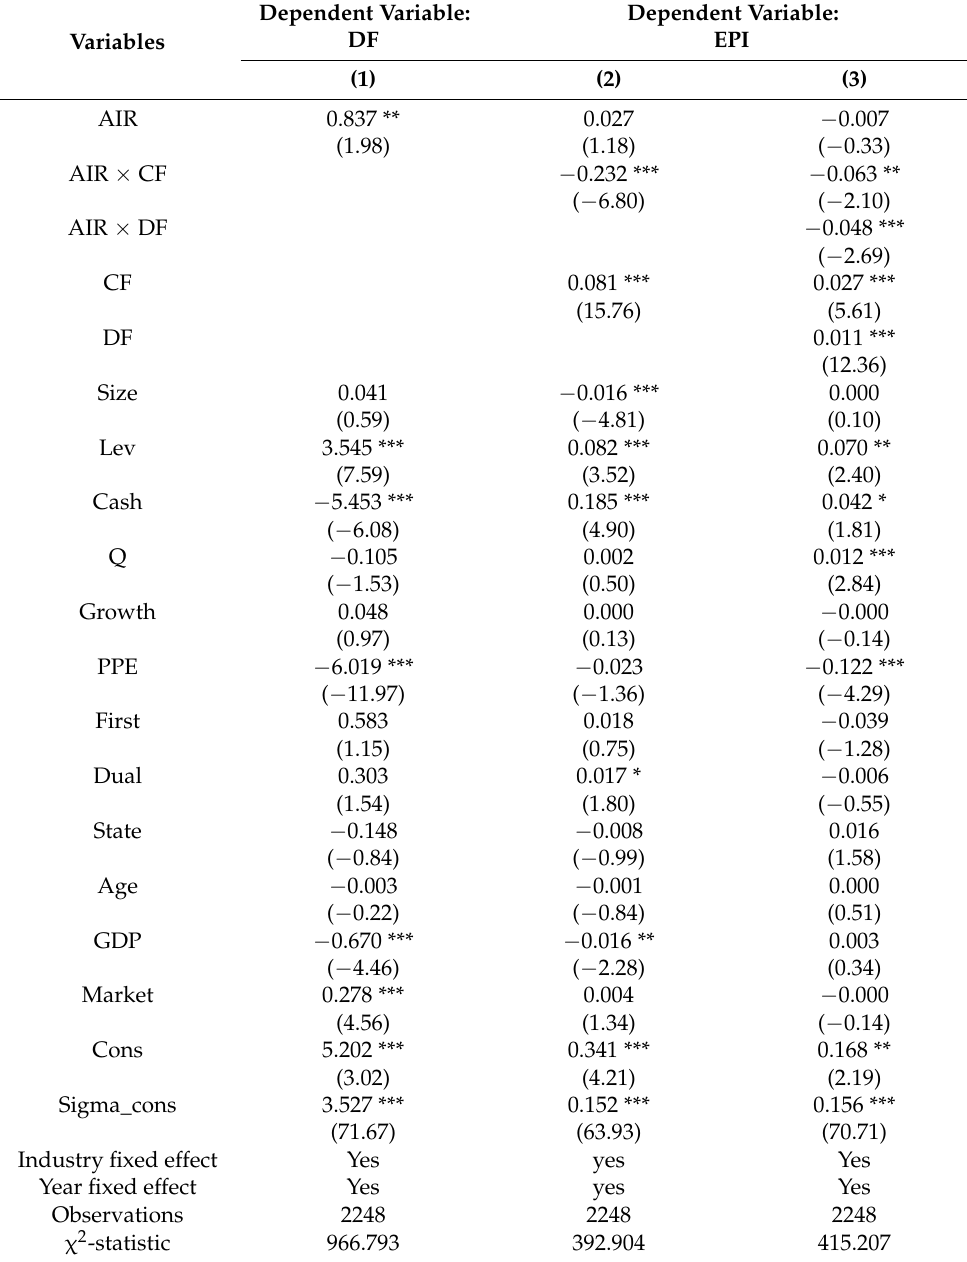
Table 13. Mediating